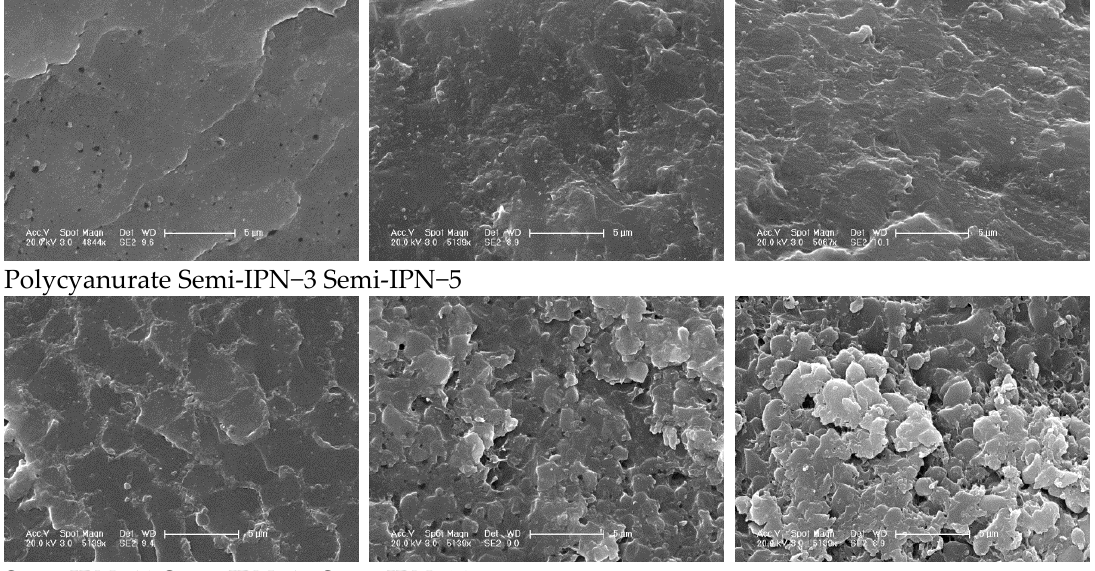
Figure 5. SEM images of polycyanurate and semi-IPNs.